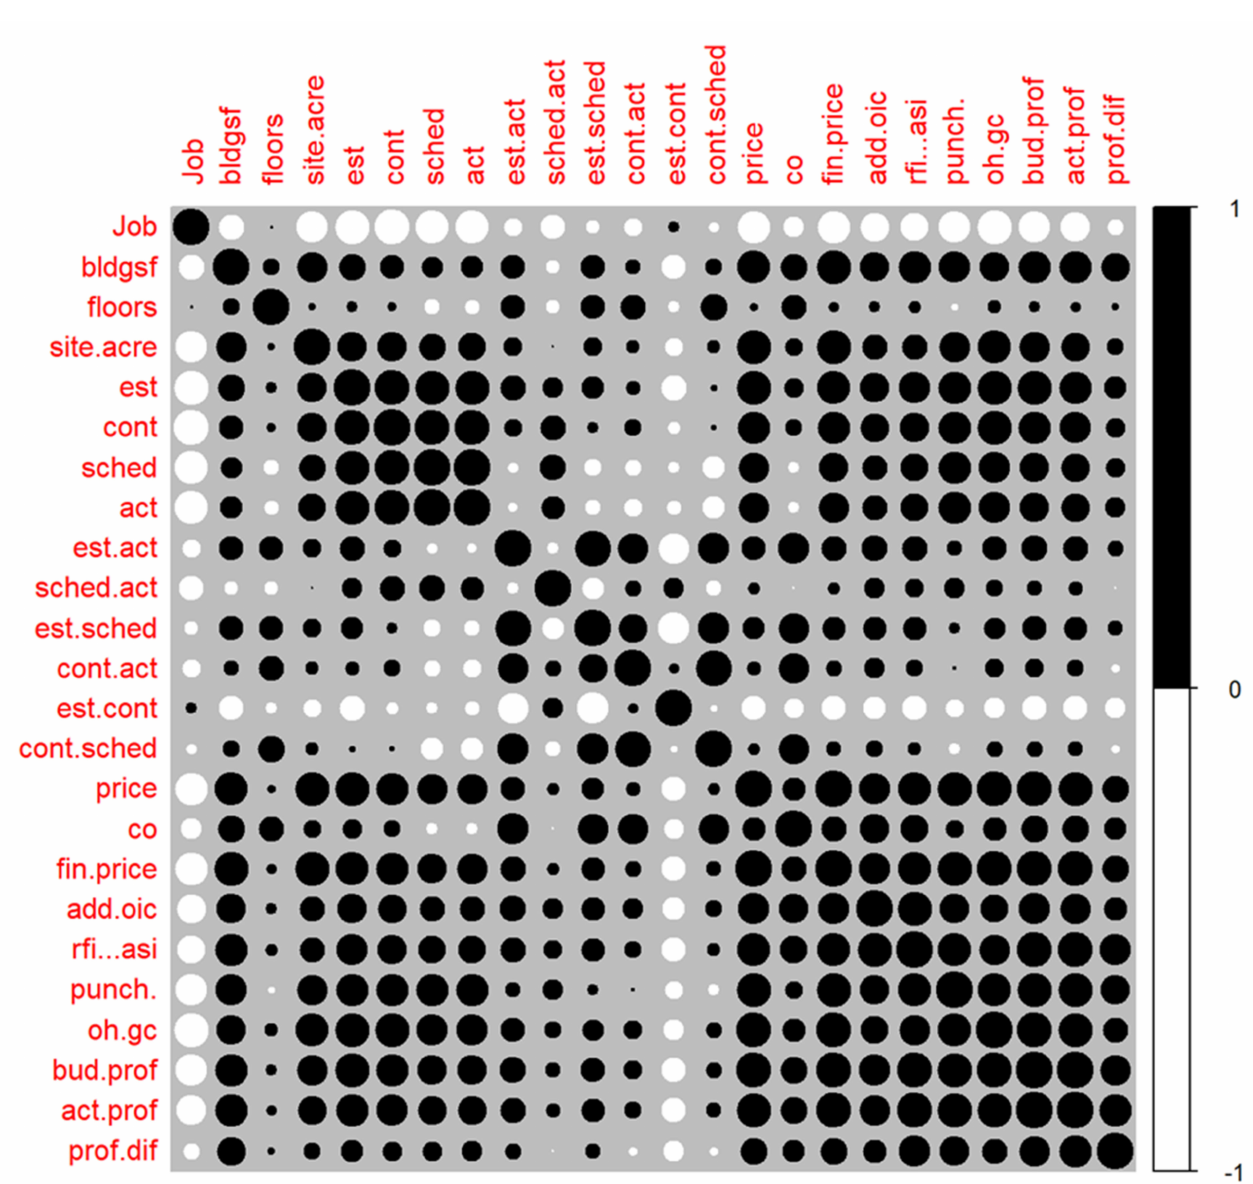
Figure 3. Correlation matrix of project data factors, shown graphically. There were 23 factors tested for correlation. Each factor has a correlation of 1 with itself, resulting in a total of 253 possible relationships between factors. The threshold of |0.7|+ indicates a strong correlation [34] and is considered significant for this analysis. The statistical analysis of the data factors from this project group resulted in 66 significant correlations among all factors, and these are shown in Table